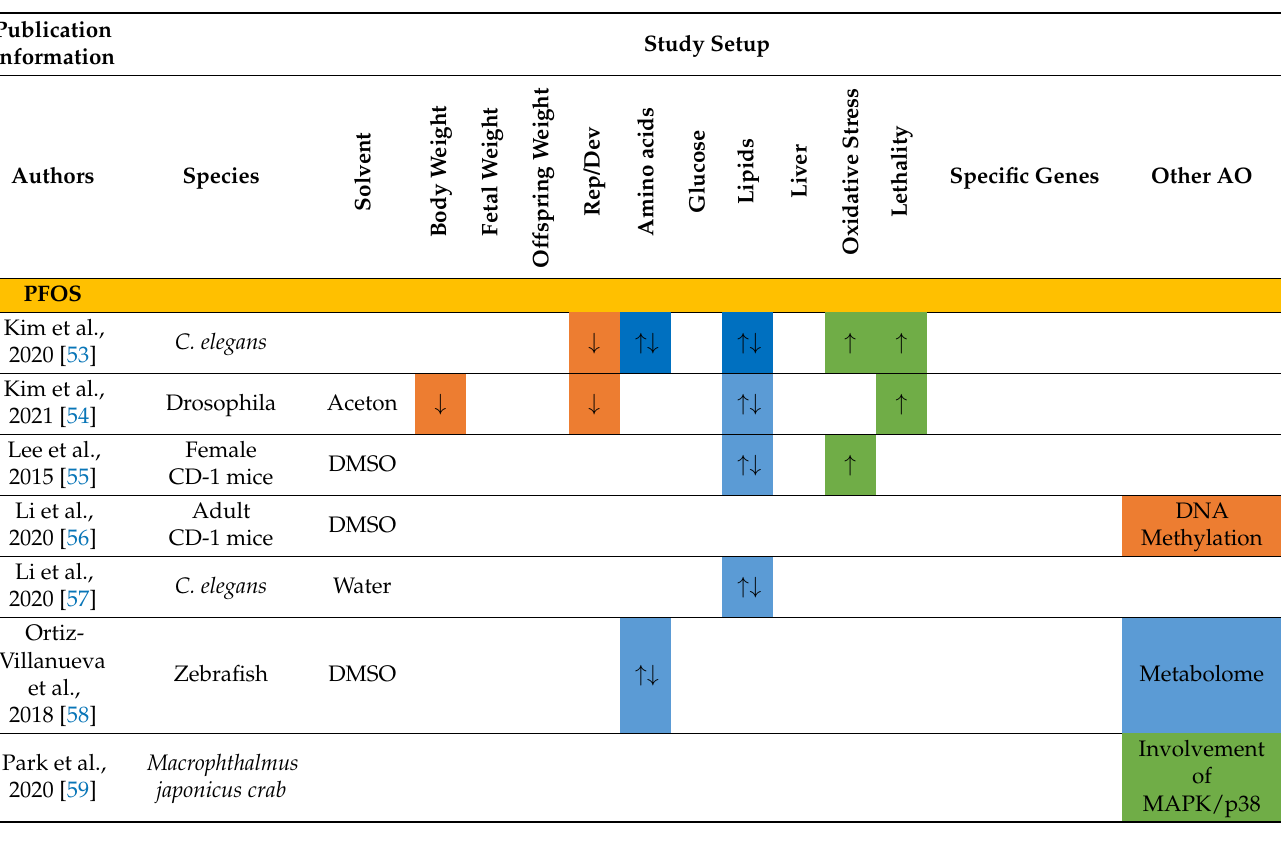
Figure 1. The sequence of the AOP-helpFinder search. Table 4. In vivo results related to PFAS exposures and oxidative stress .